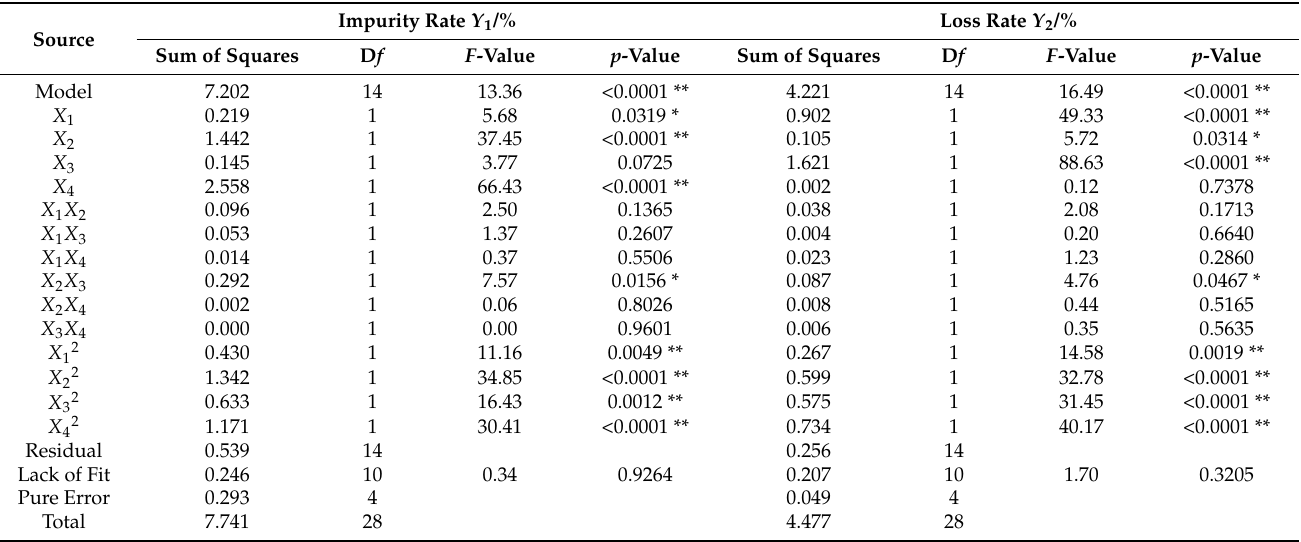
Table 4. Experimental design and response values.